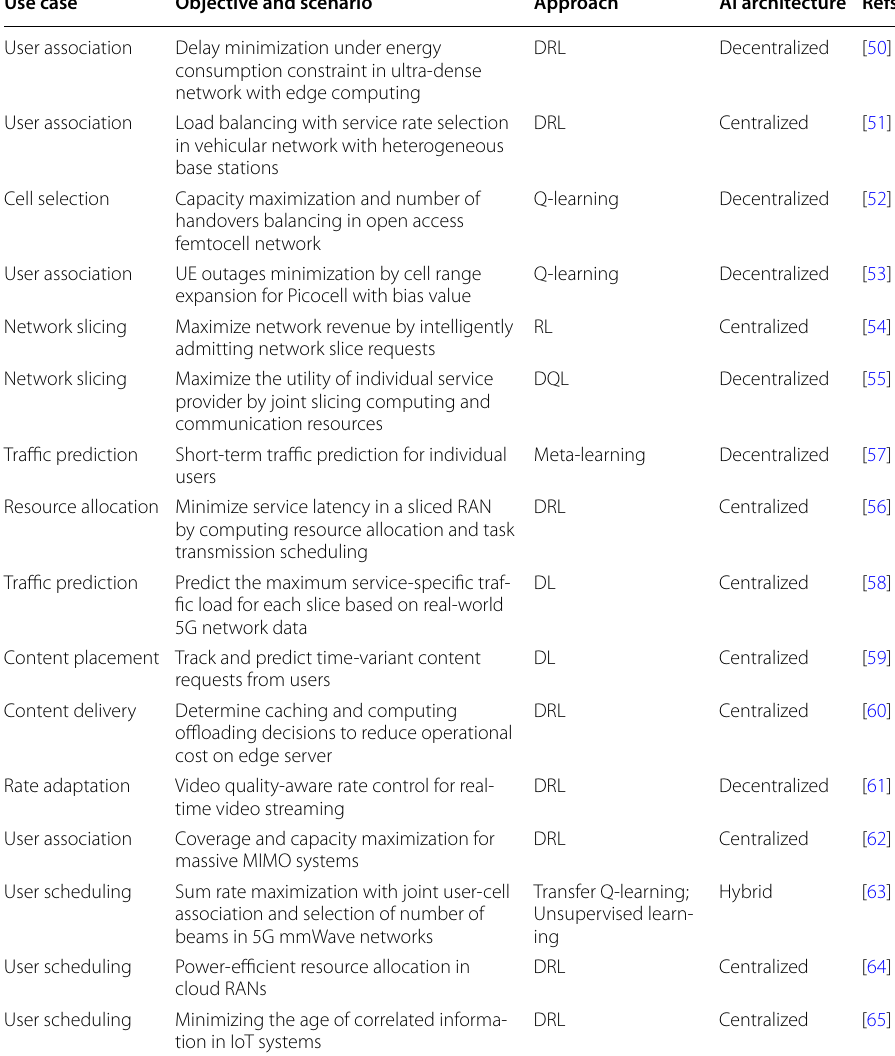
Table 3 Network management and optimization for 5G networks using ML Use